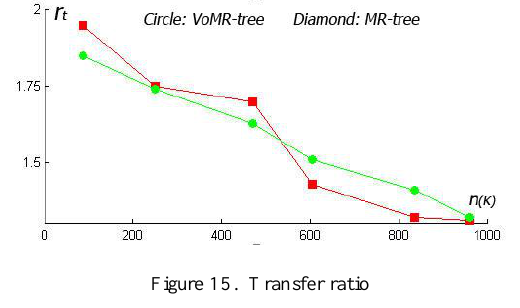
Figure 15. Transfer